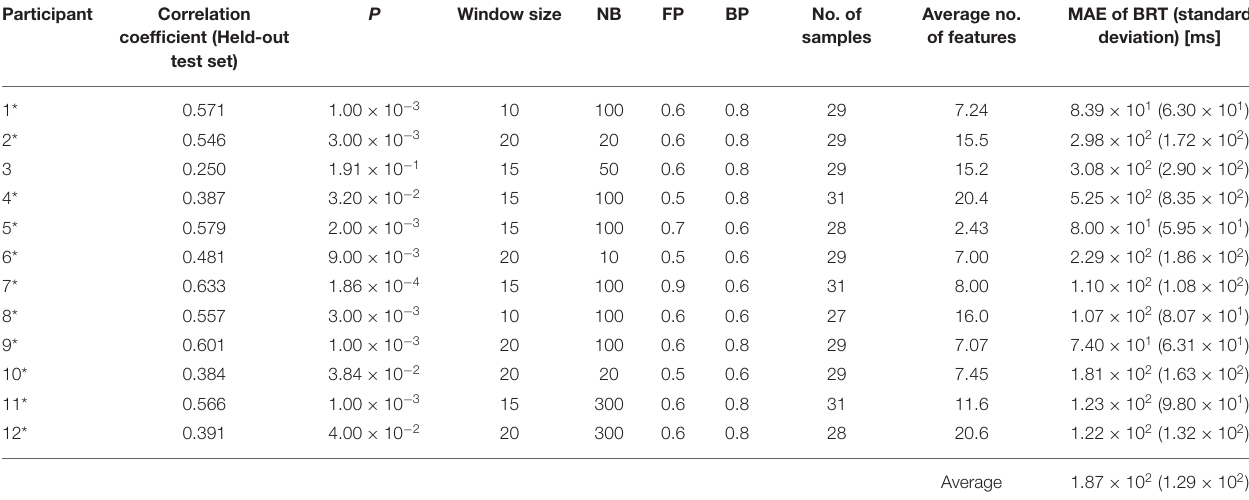
Average no. MAE of BRT (standard samples of features deviation)